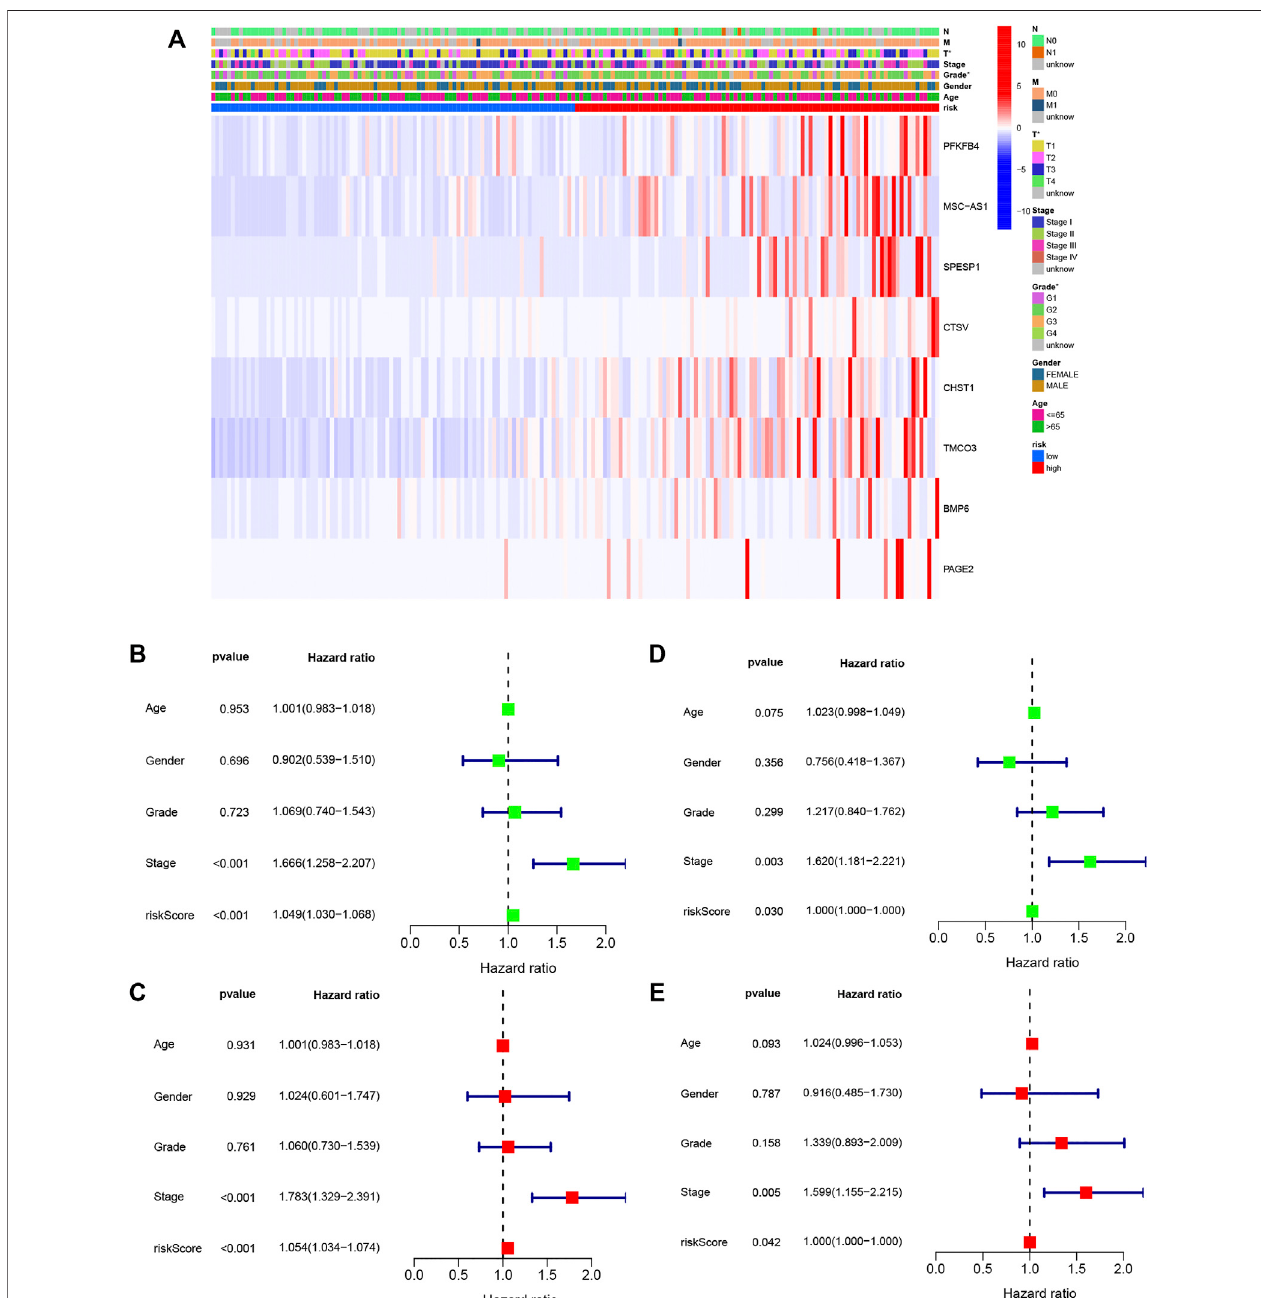
FIGURE6| Relationshipsbetweensignatureriskscoresandclinicopathologicalparameters. (A) HeatmapshowingtheexpressionofeightDENRGsintermsofthe OS signature and clinicopathological characteristics. (B) Univariate analysis of all parameters of the training set OS. (C) Multivariate analysis of all parameters of the training set OS. (D) Univariate analysis of all parameters of the validation set OS. (E) Multivariate analysis of all parameters of the validation set OS. * p < 0.05.